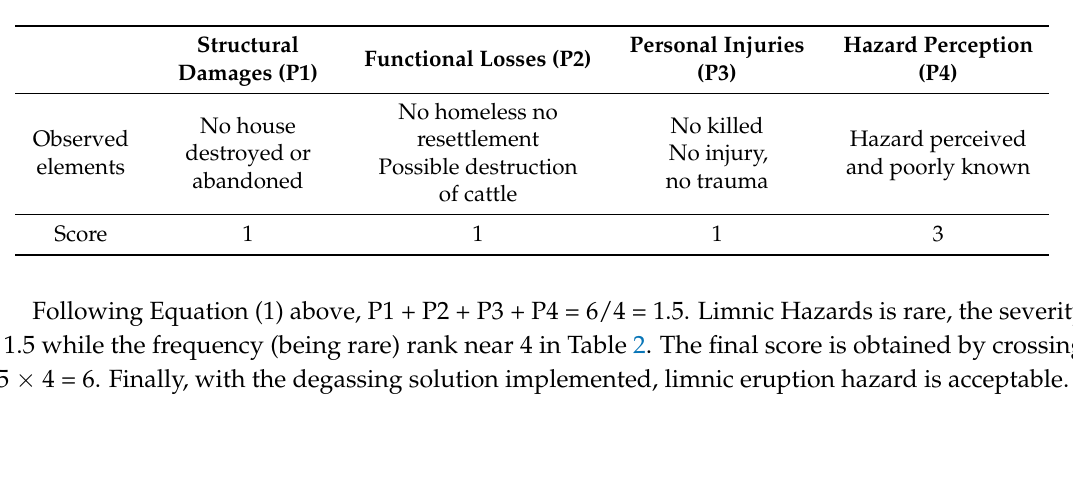
Table 8. Severity assessment of the lake Nyos limnic hazards after degassing.